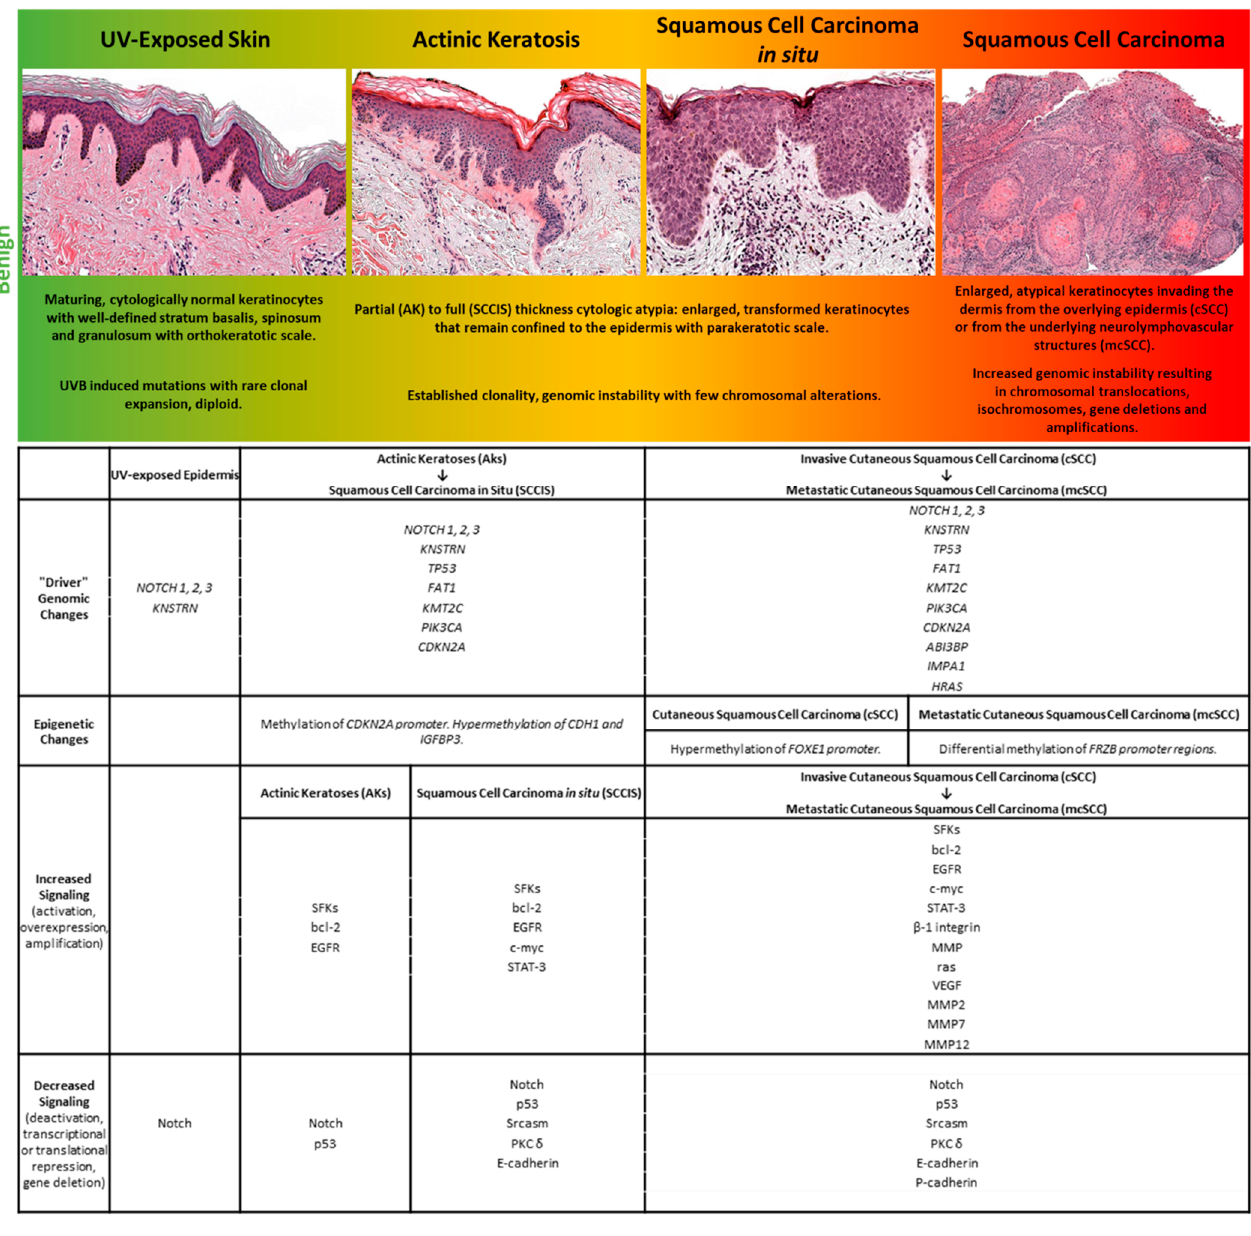
Figure 1. A representation of stages within the spectrum of human cutaneous neoplasia is shown with select histologic and molecular features.